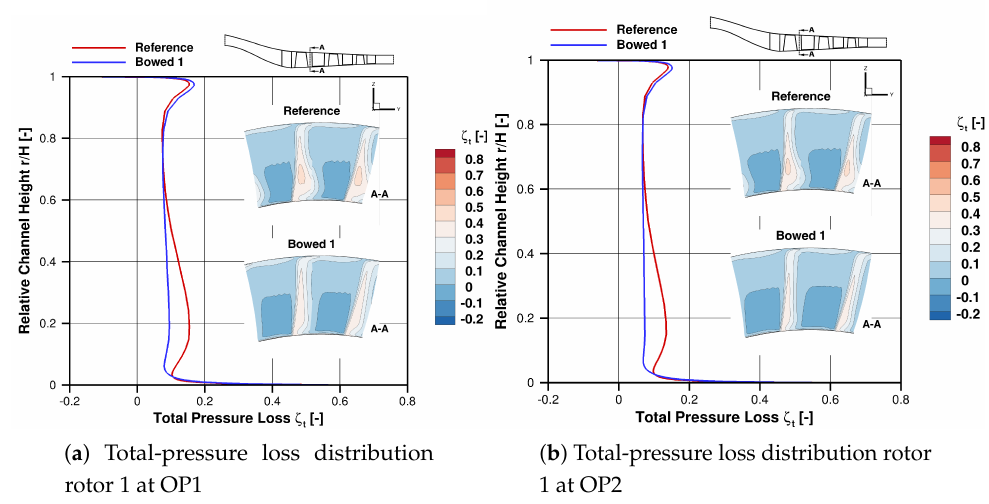
Figure 16. Effect of sweep and lean on rotor 1 at off-design.